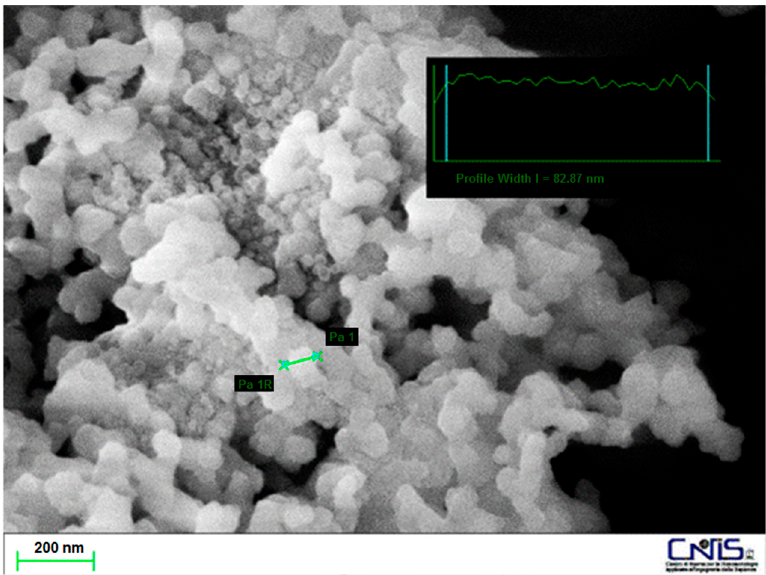
Figure 4. SEM image of the sulfur particles produced by means of SDR.